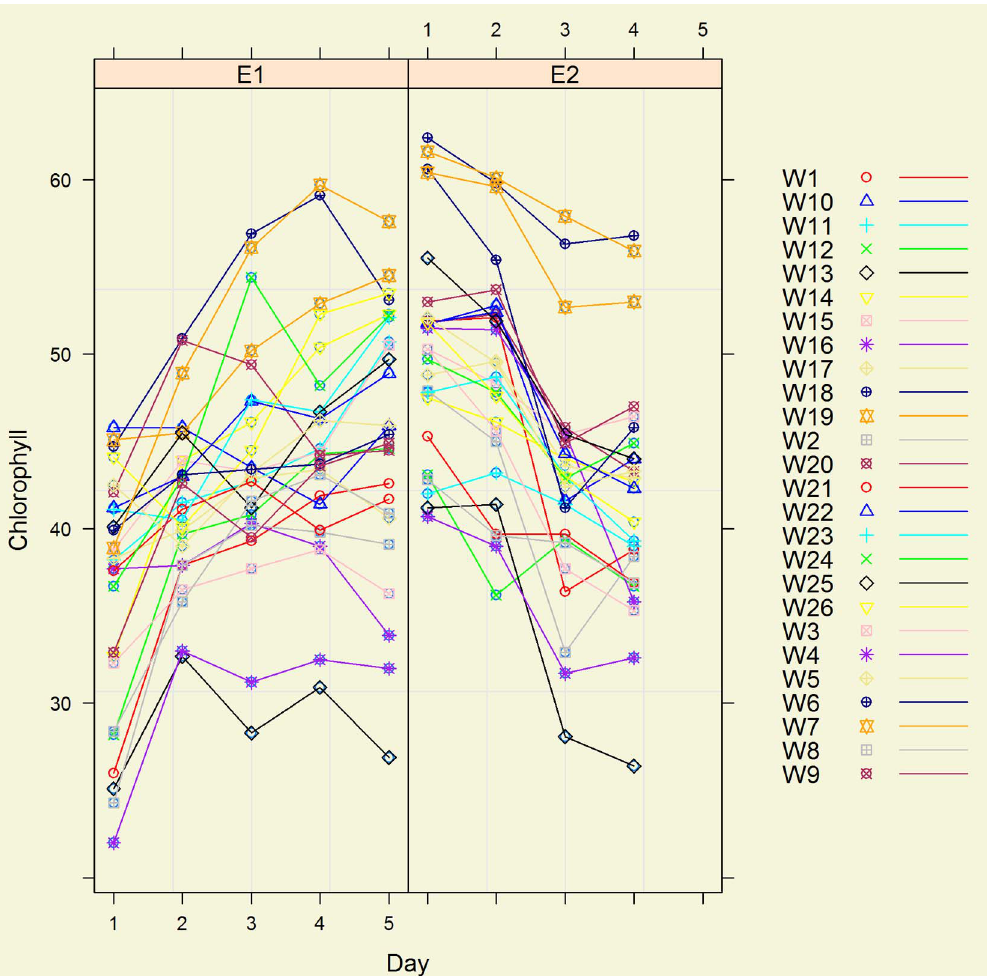
Figure 4. Wheat genotypes (W1–W26) SPAD units (Chlorophyll) in environments E1 (field based high fertility) and E2 (winter glasshouse) taken on 5 days in experiment 3.